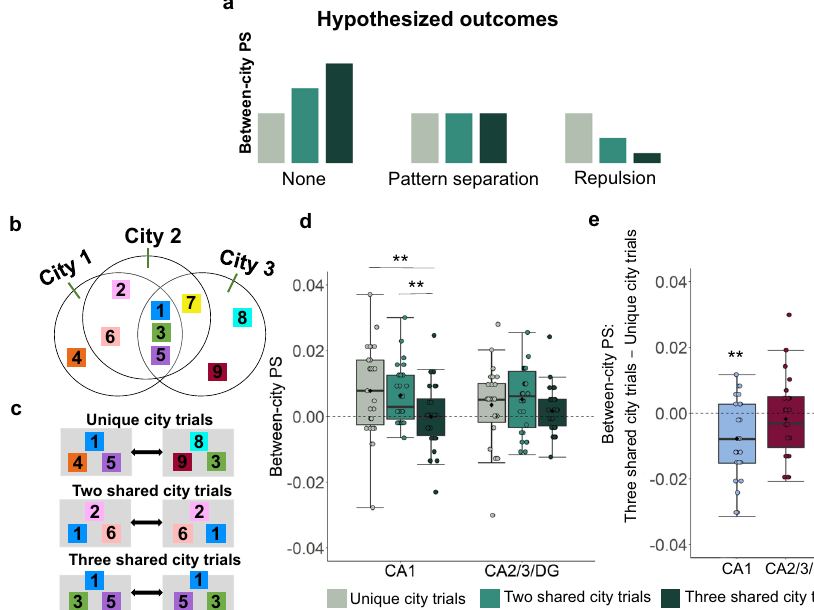
Fig. 3 Multivariate pattern similarity analysis (MPS) of differentiated representations for shared city trials in the hippocampus. a Hypothesized outcomes for shared city trial representations. First, if the memory representation of trials shared between cities is the same, the between-city PS of shared city trials should be higher than the between-city PS of unique city trials (left panel). Second, if the memory representation of the shared city trials is orthogonal between cities (i.e., due to pattern separation), the between-city PS of shared city trials should be comparable to the between-city PS of unique city trials (middle panel). Third, if repulsion occurs, the between-city PS for the shared city trials should be lower than trials unique to a different city (right panel). b Venn diagram depicting store overlap across the three environments, same as Fig.1b. c Examples of three kinds of shared city trials/conditions.